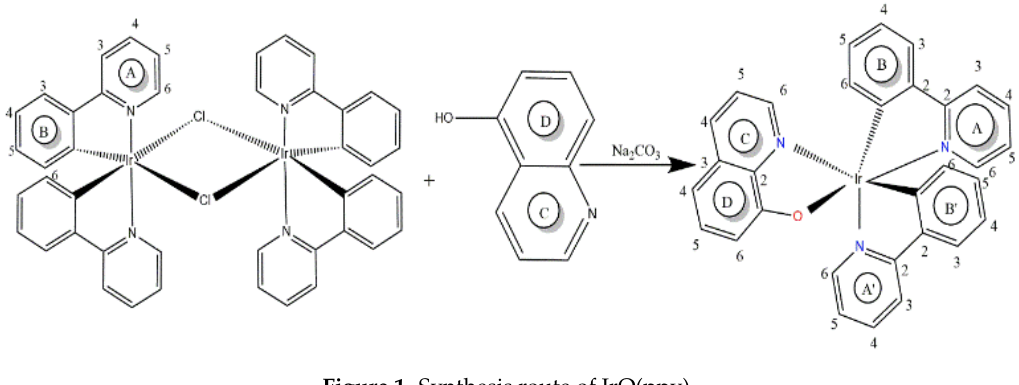
Figure 1. Synthesis route of IrQ(ppy) 2 .